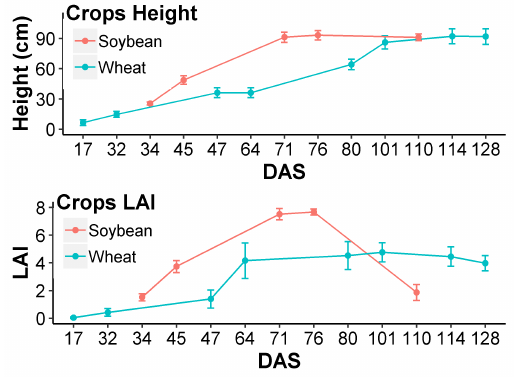
Figure 2. Mean (black line) and standard (error bar) deviation for Sigma 0 (dB), Gamma 0 (dB), Entropy and Alpha angle for soybean crop.